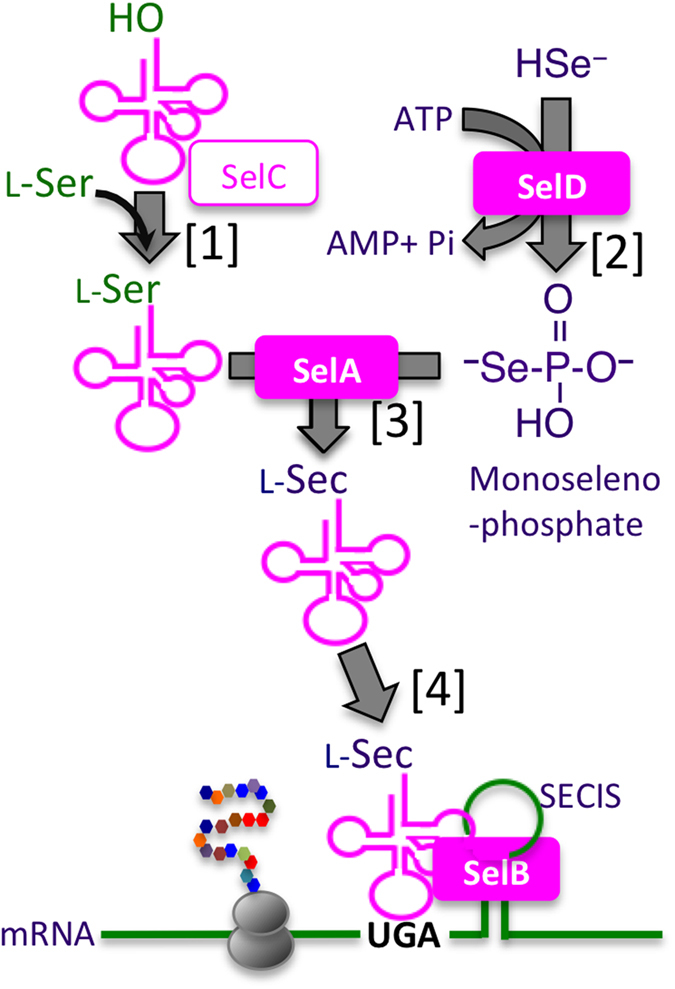
Decoding an in-frame opal codon (UGA) by selenosome.Sec is directed by the in-frame opal codon (UGA), and is synthesized on a specific tRNAUGA (selC product) that is initially charged with L-serine [1]. A reactive selenium donor compound, monoselenophosphate, is synthesized from ATP and selenide by the catalysis of selenophosphate synthetase, the selD product [2]. L-Sec-tRNAUGA is synthesized by L-selenocysteine synthase, selA product, which converts L-Ser to L-Sec on the tRNAUGA [3]. SelB is an elongation factor, which binds to L-Sec-tRNA and the stem-loop structure, SECIS element, designating the position to incorporate L-Sec in a growing polypeptide chain [4].